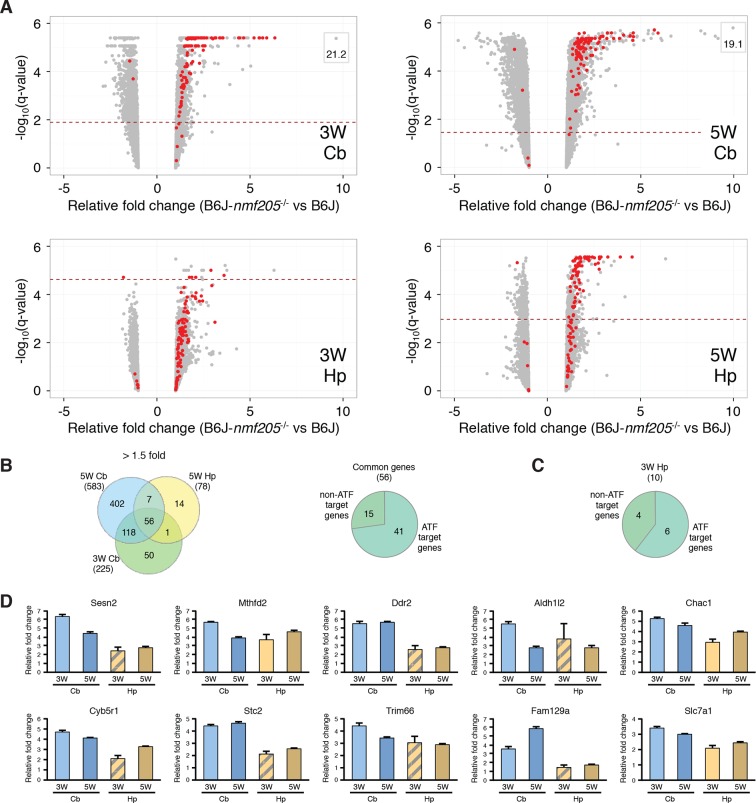
ATF4 downstream genes are robustly activated in B6J-Gtpbp2nmf205-/- mutant brain.(A) Volcano plots of ATF4 downstream genes demonstrating activation of the ATF4 pathway in the B6J- Gtpbp2nmf205-/- (B6J-nmf205-/-) brain. Fold change and q values of all genes are shown and ATF4 target genes, obtained from previous ChIP-Seq studies as described in the text, are red. Genes with very high levels of induction are shown in boxes to fit on the scale. Note that although induction of ATF4 downstream genes is observed in all groups, upregulation of these genes occurs earlier and is most robust in the cerebellum. (B) Venn diagram of differentially expressed genes between B6J and B6J-Gtpbp2nmf205-/- 3-and 5-week cerebellum and 5-week hippocampus. Note that a large number of genes (56 genes) are consistently upregulated between cerebellum and hippocampus and that most of these genes are known ATF4 target genes. (C) The distribution of ATF4 target genes in the upregulated gene set from the B6J-Gtpbp2nmf205-/- 3-week hippocampus. (D) The relative fold change (RFC) of the top ten upregulated genes in the 3-week-old B6J- Gtpbp2nmf205-/- cerebellum for each time point and brain region. RFCs depicted with solid bars were significant changes (p<0.05) and those depicted by hatched bars were not.DOI:
http://dx.doi.org/10.7554/eLife.14295.01110.7554/eLife.14295.012Figure 2—source data 1.Differentially expressed ATF4 target genes.DOI:
http://dx.doi.org/10.7554/eLife.14295.01210.7554/eLife.14295.013Figure 2—source data 2.Common differentially expressed genes.